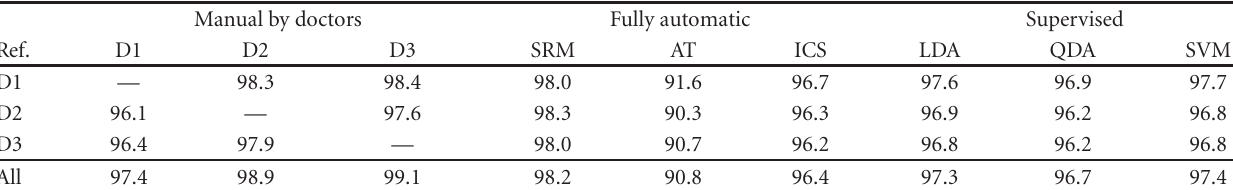
Table 2: Average accuracy of segmentation, quantified by the specificity (%), showing the performance of the proposed ICS method against alternative solutions. Borders manually drawn by three dermatologists, and their agreement, are considered as the ground-truth reference for accuracy assessment.